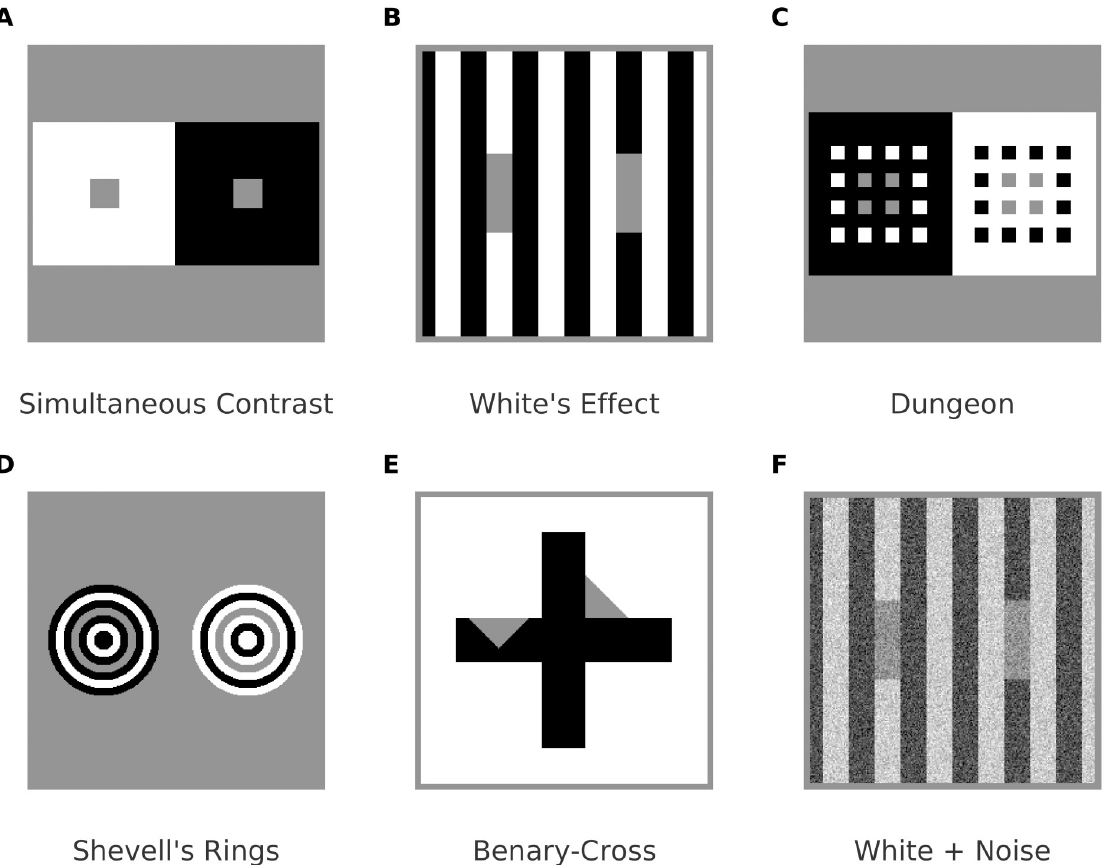
Fig 1. (A) Simultaneous brightness contrast: The two gray patches with identical luminance increase their brightness difference with their respective backgrounds. (B) White’s effect is consistent with contrast at the horizontal contours of the bars, and with assimilation along the vertical contours. (C, D) Examples of brightness assimilation: The gray structures with identical luminance decrease their brightness difference with their respective background. (E) Sensitivity to context: The gray triangles have identical luminance and selectively contrast with the cross (left) or the background (right). (F) White’s effect is still intact in the presence of noise.